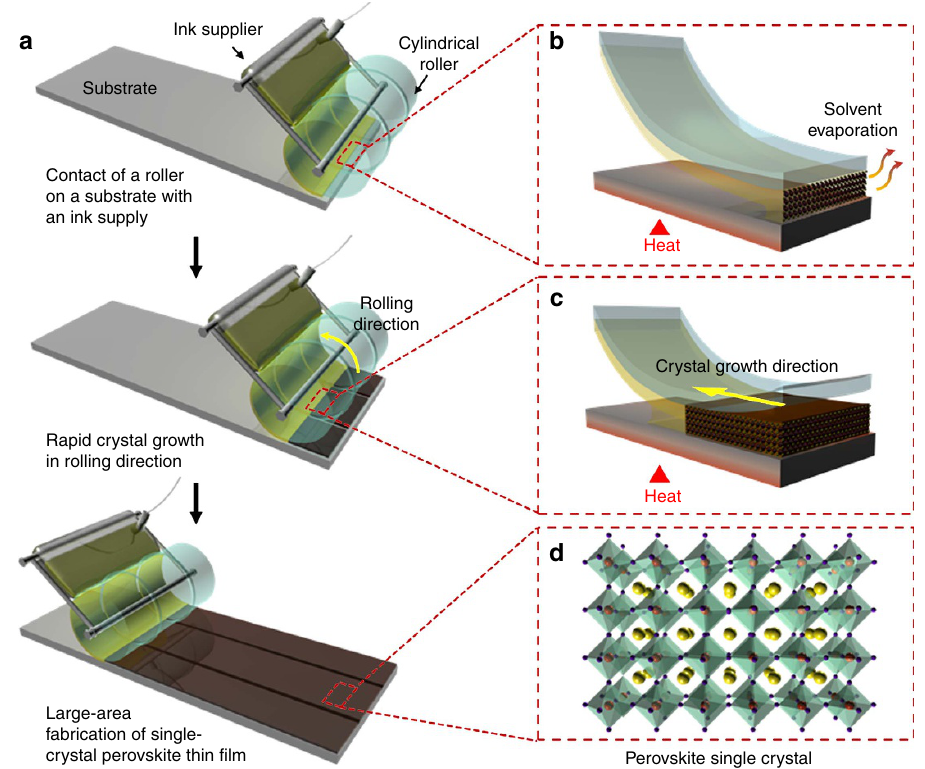
Figure 1 | Fabrication of single-crystal perovskite patterned thin films. ( a ) Schematic of the manufacturing procedure for single-crystal perovskite thin films using geometrically confined lateral crystal growth (GC-LCG) with a rolling mould. The perovskite ink solution is geometrically confined between the mould and the substrate; thus, crystal growth is restricted in one direction. By rolling the mould and continuously supplying ink to the substrate, large-area single-crystal perovskite patterned thin films grow along the rolling direction. ( b ) Schematic illustration of the rapid solvent evaporation occurring at the open end of the channel. ( c ) Schematic illustration of the geometrically confined crystal growth along the channels of the mould. ( d ) Crystal structure of the single-crystal CH 3 NH 3 PbI 3 perovskite thin films (yellow sphere: CH 3 NH 3 þ , red sphere: Pb 2 þ , violet sphere: I (cid:3)